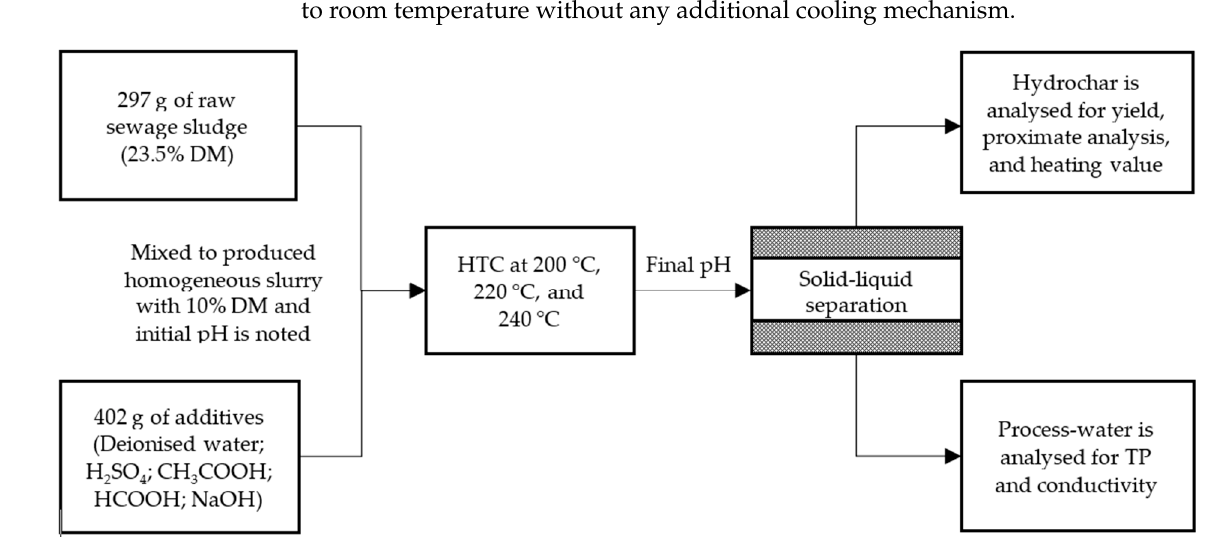
Figure 1. Schematic representation of experimental methodology.